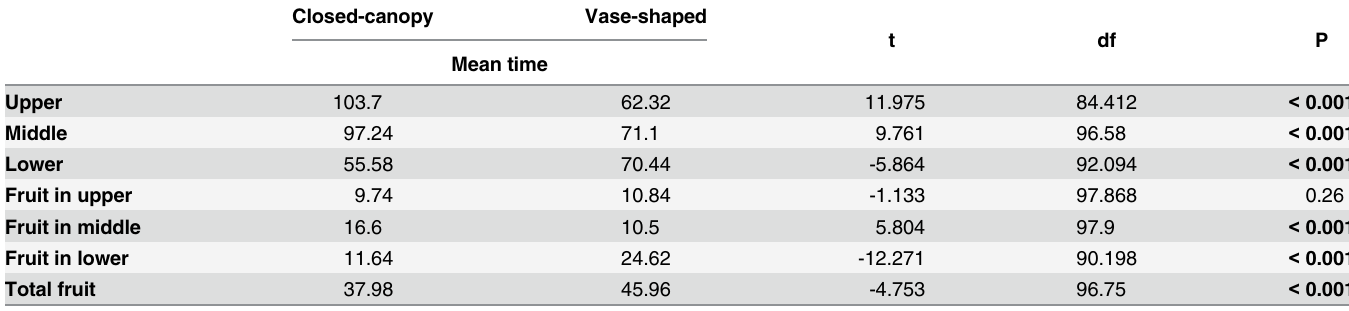
Table 3. The comparison of mean time (min) spent by 30 Bactrocera tryoni on the vegetation volume and host fruit in each part of the two types of tree